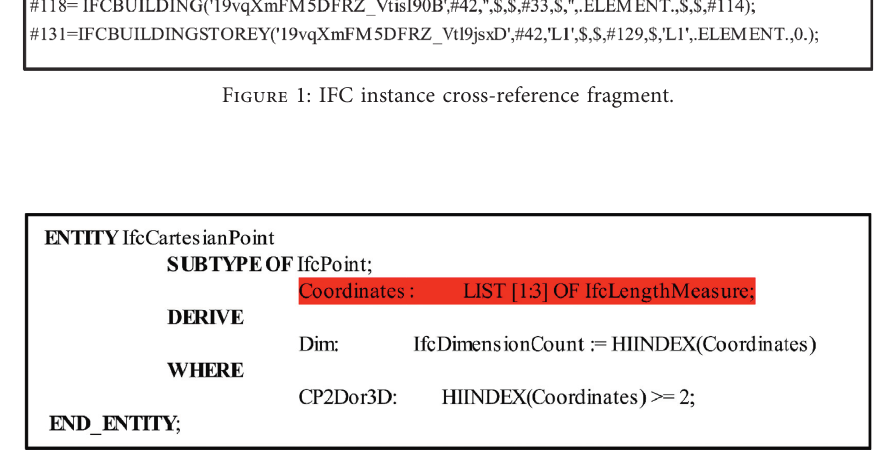
Figure 2: EXPRESS document description of IfcCartesianPoint